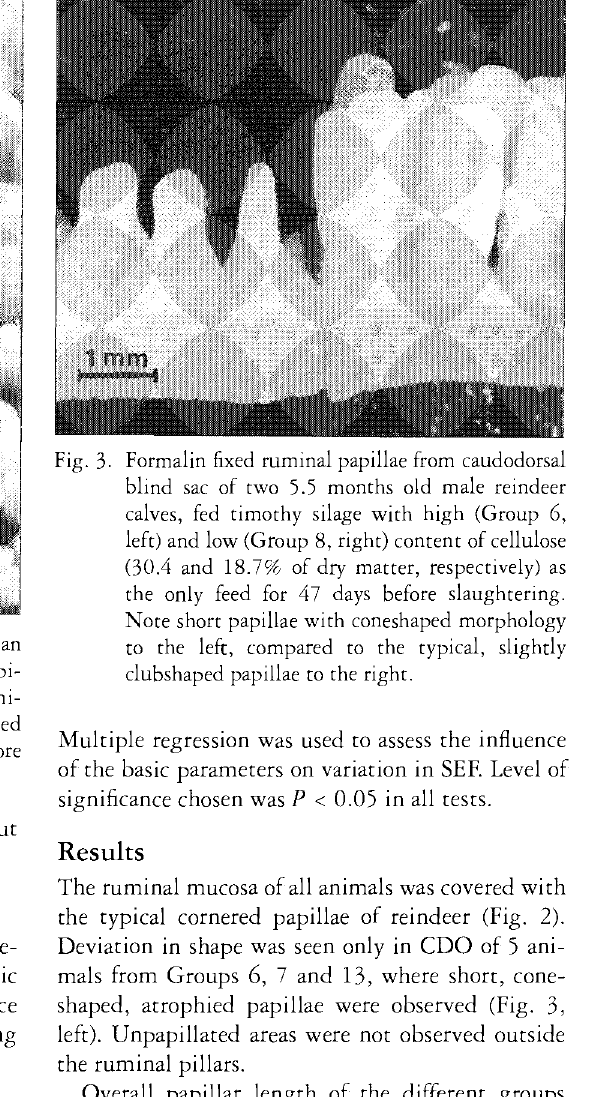
Fig. 3- Formalin fixed ruminal papillae from caudodorsal blind sac of two 5.5 months old male reindeer calves, fed timothy silage with high (Group 6, left) and low (Group 8, right) content of cellulose (30.4 and 18.7% of dry matter, respectively) as the only feed for 47 days before